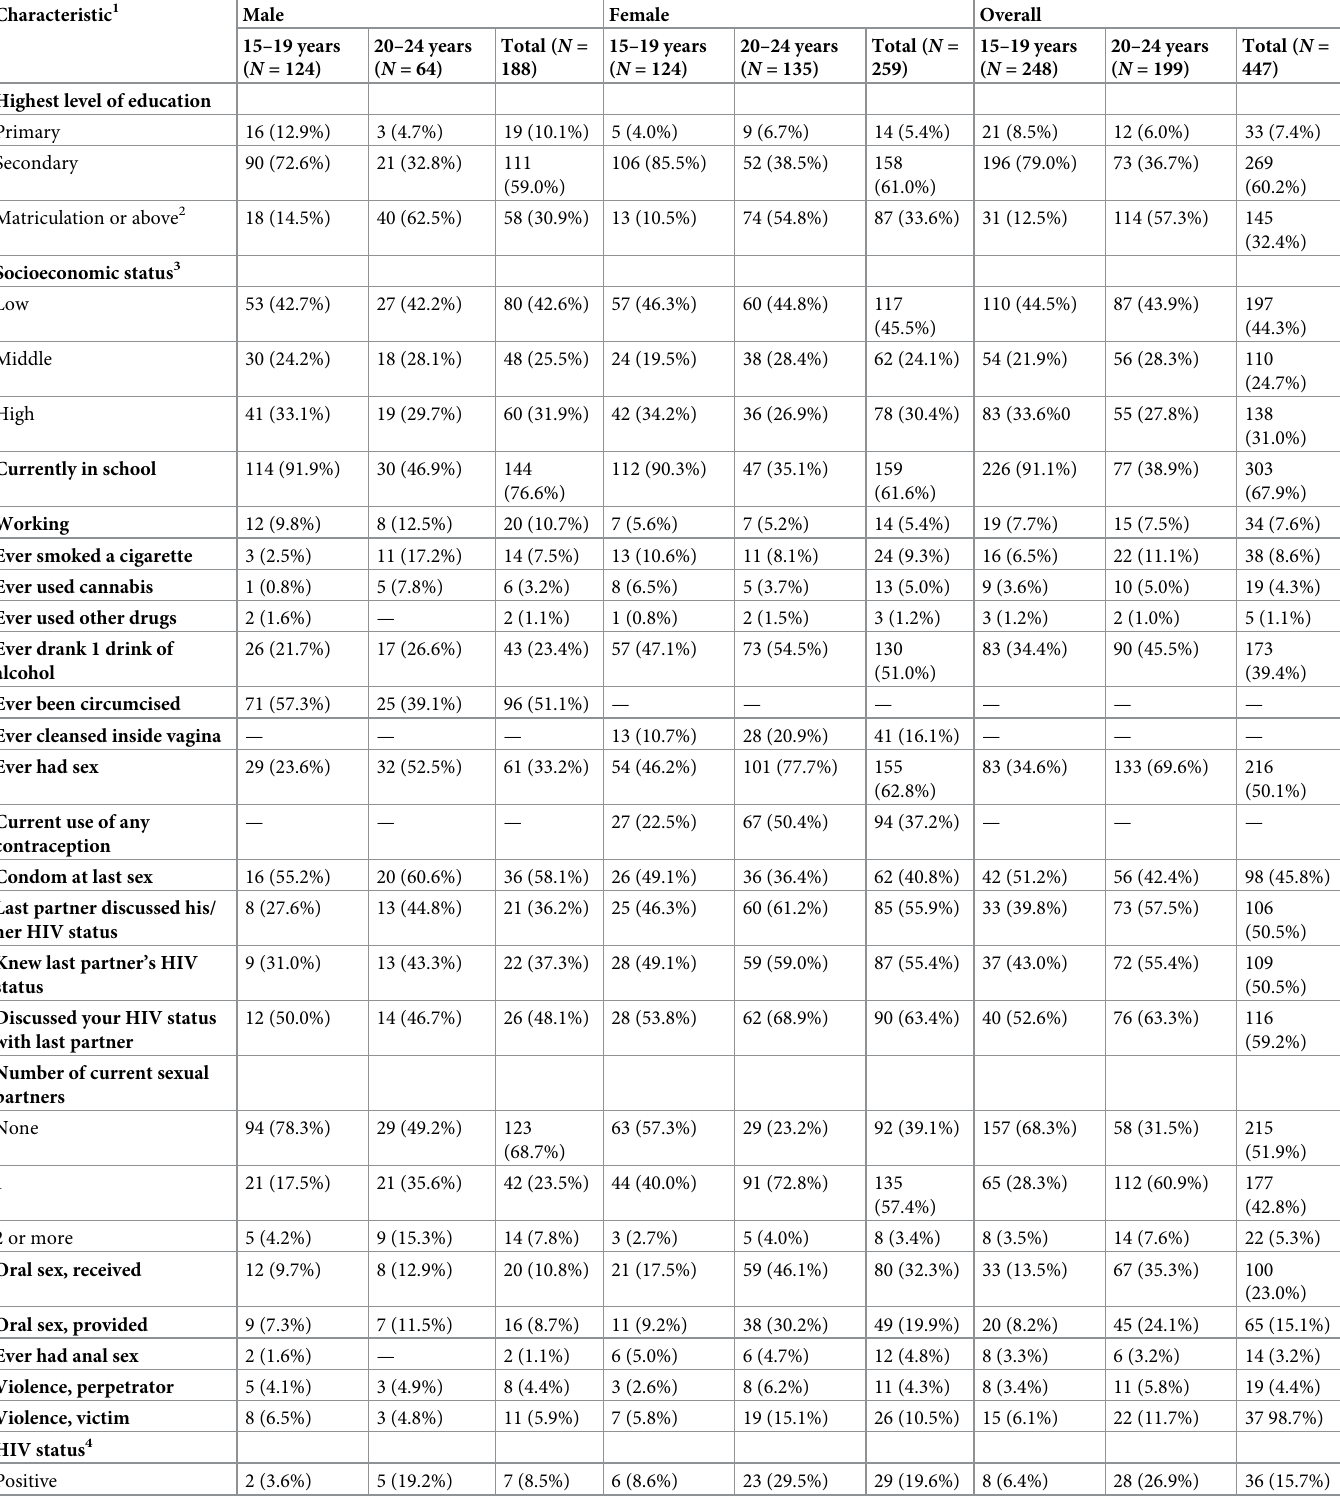
Table 1. Baseline characteristics of participants in a population-based sexually transmitted infection survey among young people aged 15–24 years in rural Kwa- Zulu-Natal ( N = 447). Characteristic